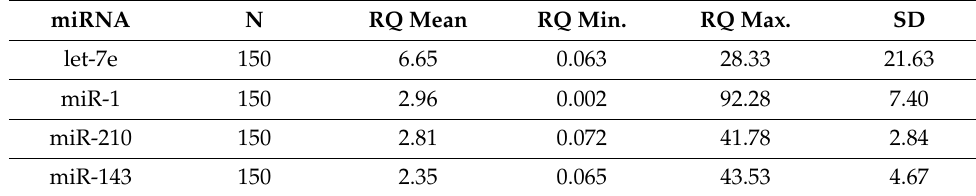
Table 4. Expression of miRNA in